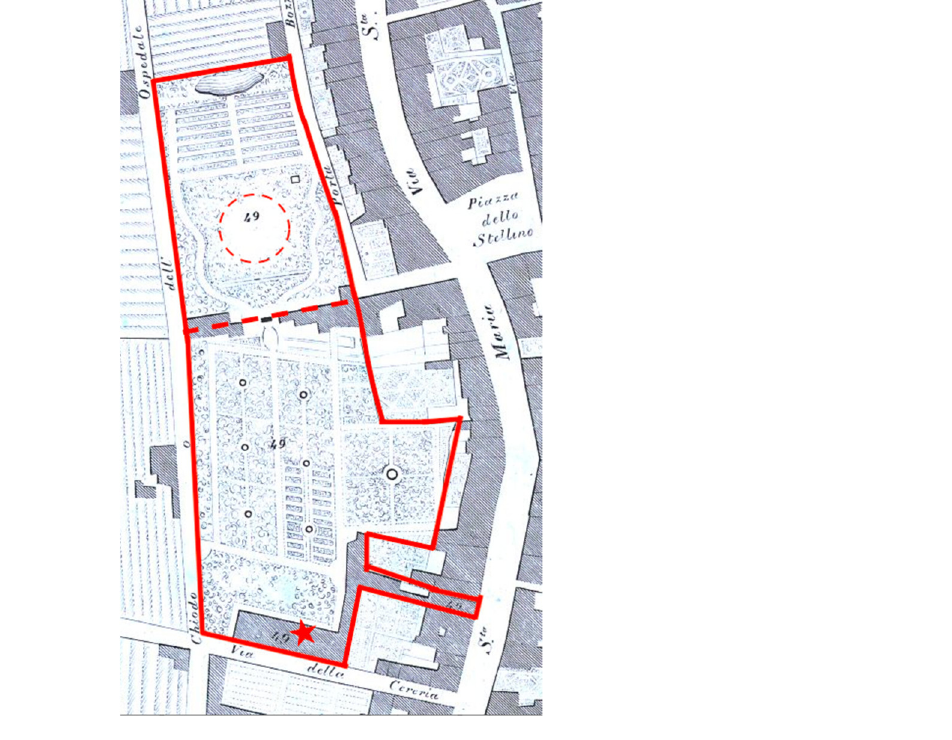
Figure 3. A detail of Van Lint’s map of Pisa (1846) showing the Botanic Garden (red solid line). North is up. The “Orto Nuovo” lies above the red dotted line; the red dashed circle shows the position of the giraffe enclosure within the “Orto Nuovo”; the red star marks the Natural History Museum building at the southern boundary of the Botanic Garden.